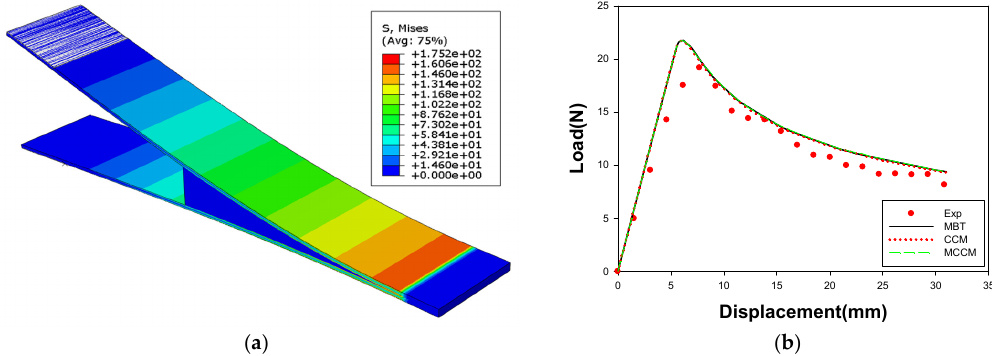
Figure 10. Result of FE simulation for the DCB test: ( a ) Distributions for effective stress; ( b ) Load-displacement curve.